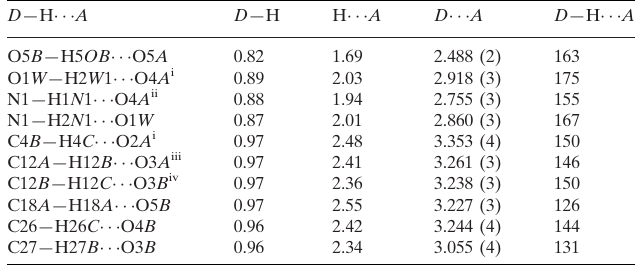
Hydrogen-bond geometry (A˚ , (cid:5)